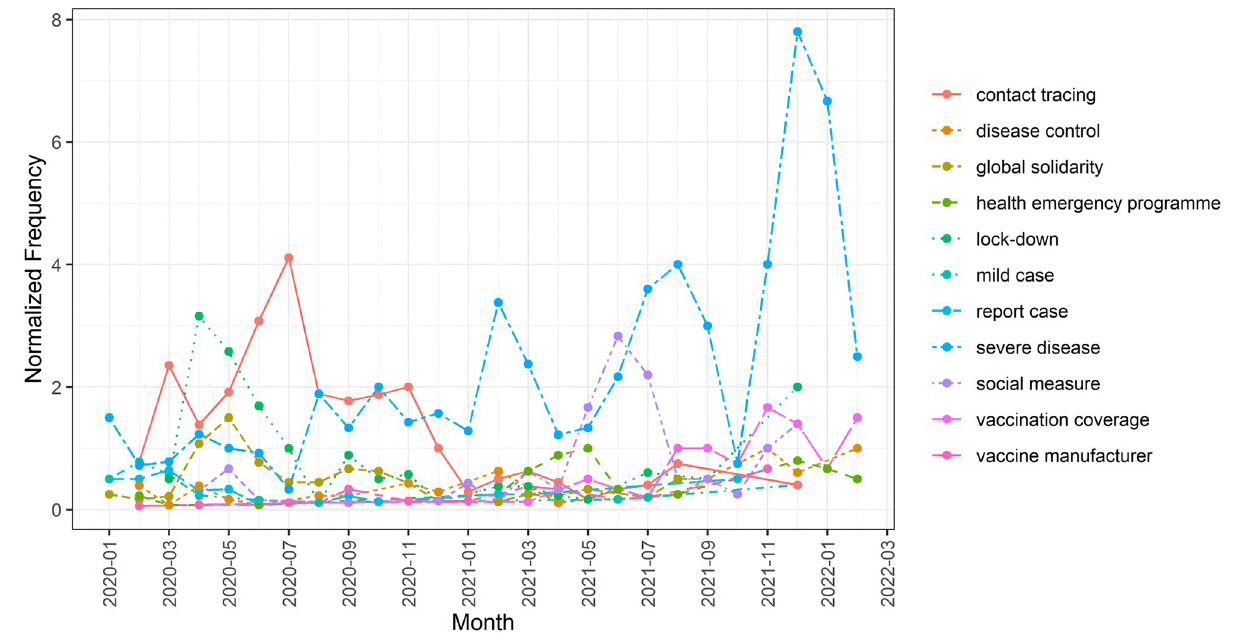
Fig 1. Trajectory of hot topics between January, 2020 and February,